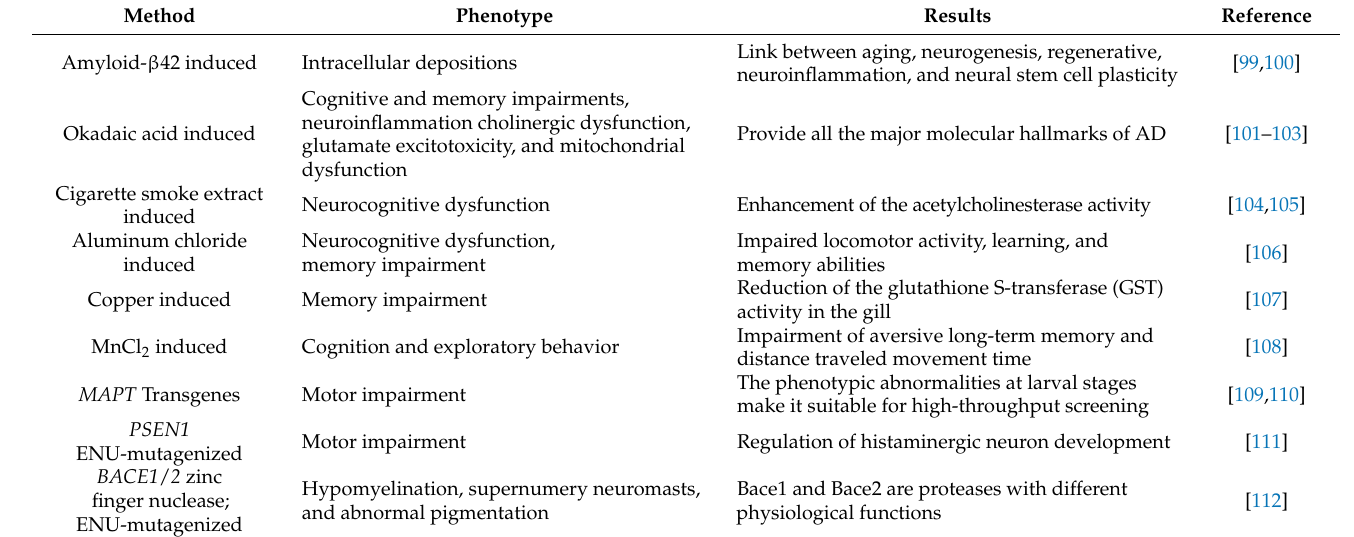
Table 2. Zebrafish models of Alzheimer’s